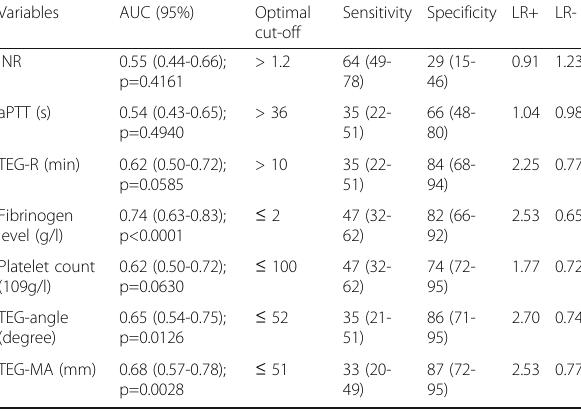
Table 1 (abstract 001648). Accuracy of thromboelastography and laboratory tests in predicting bleeding from variables assessing